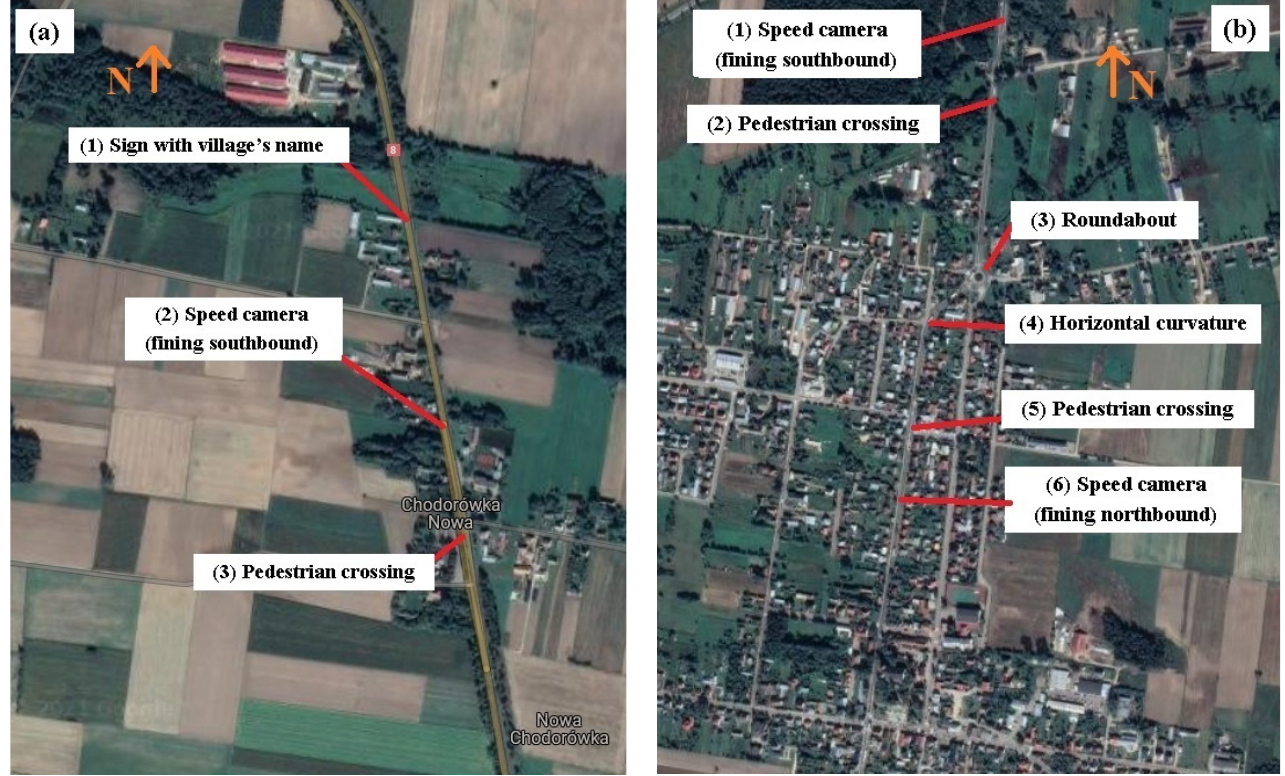
Figure 3. Locations of the traffic calming measures and other elements in ( a ) Chodorówka Nowa; ( b ) Suchowola. Vehicles speeds were measured in both directions at the three points (the entrance/exit of the village, the speed camera, and the pedestrian crossing). Points are referred to as S1, S2, and S3, when measuring southbound, and N1, N2, and N3